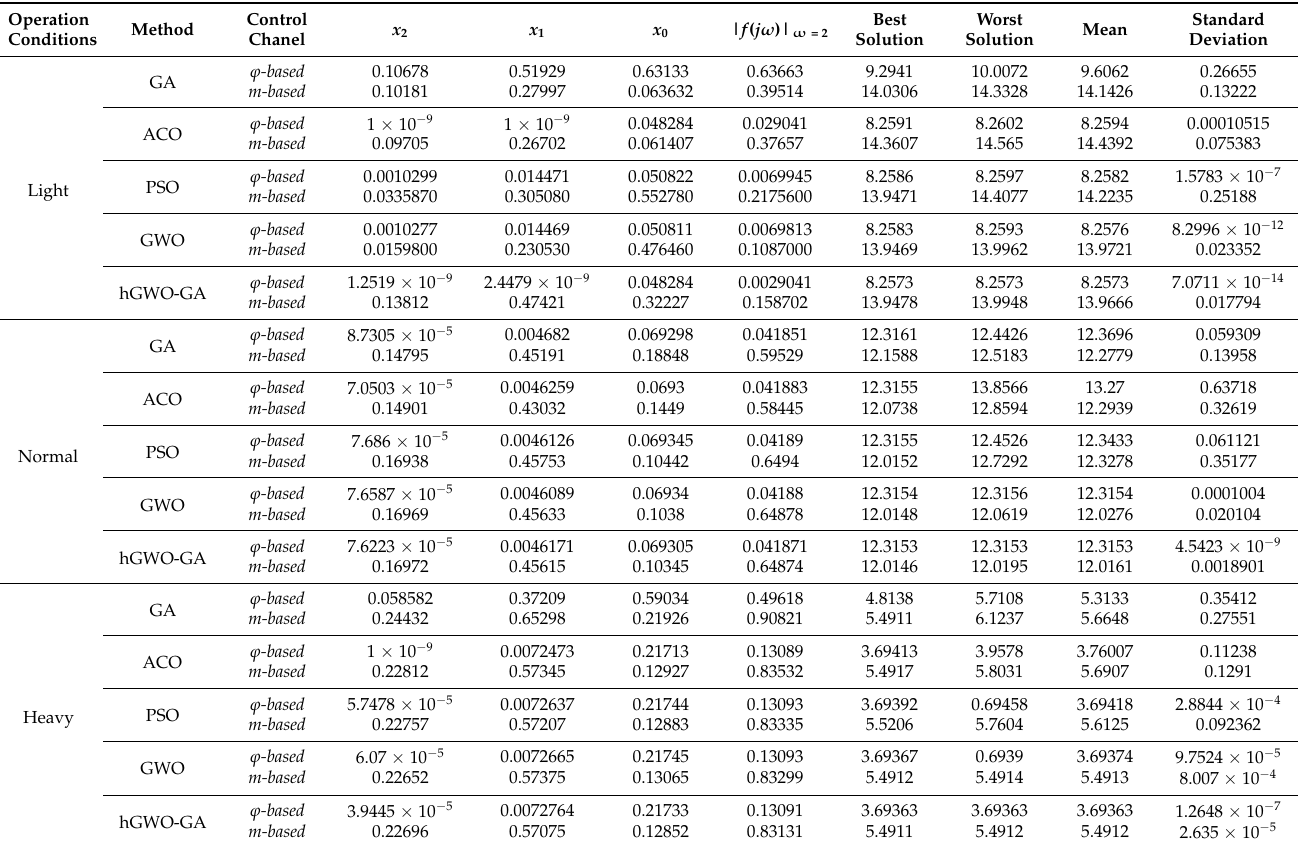
Table 4. Parameters of optimal SSSC-based